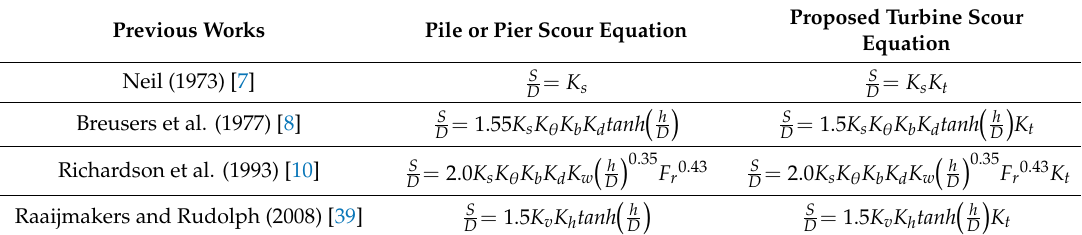
Table 5. Equations used to predict the pile or pier